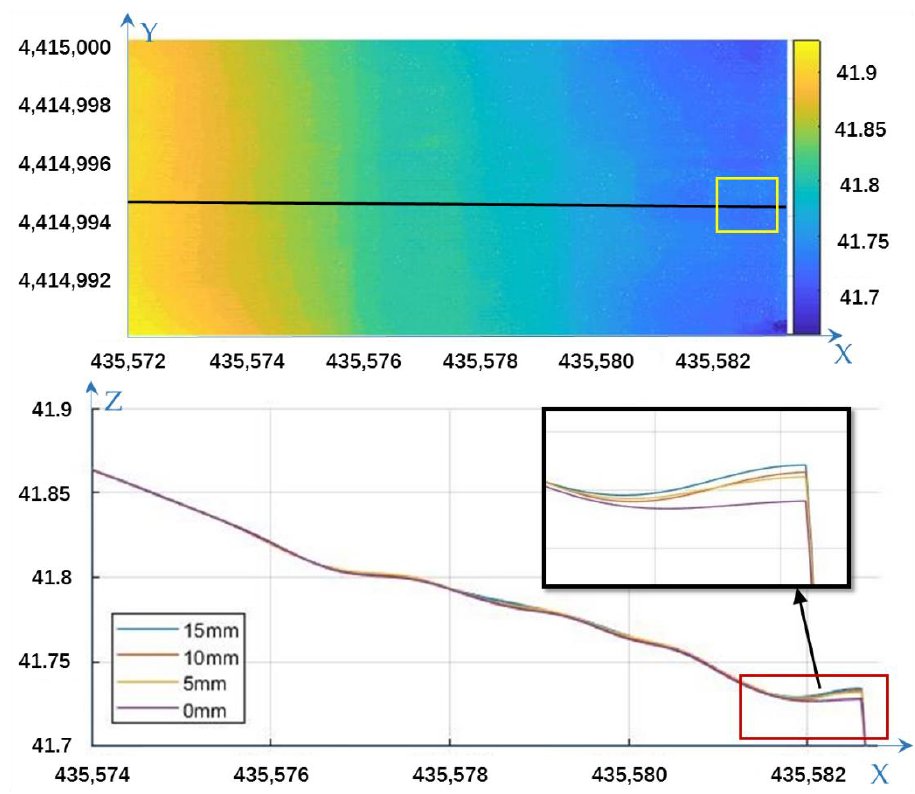
Figure 16. The profiles for all sets of Gaussian smoothing results (m).